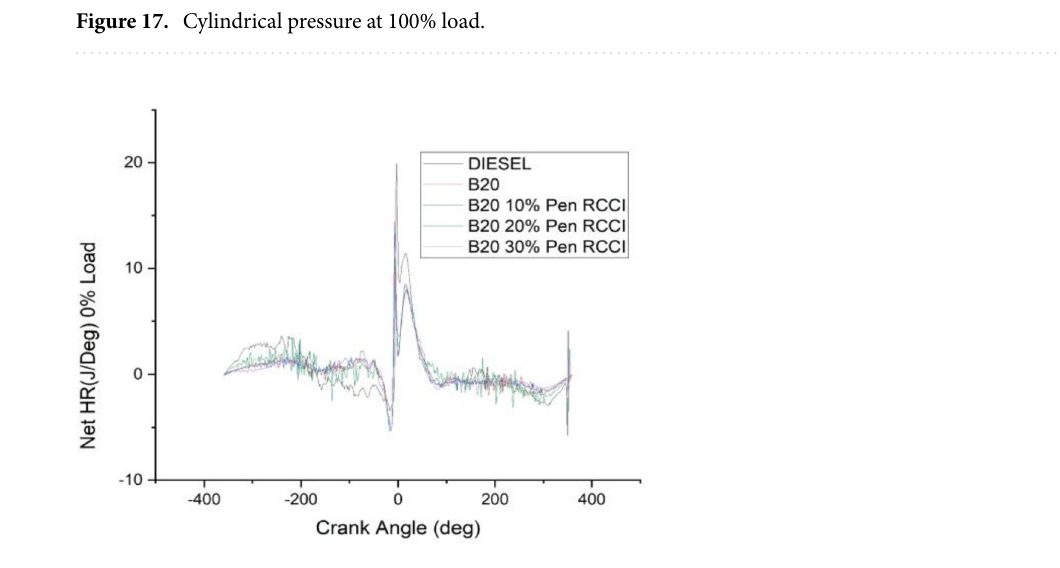
Figure 18. Net heat release at 0%